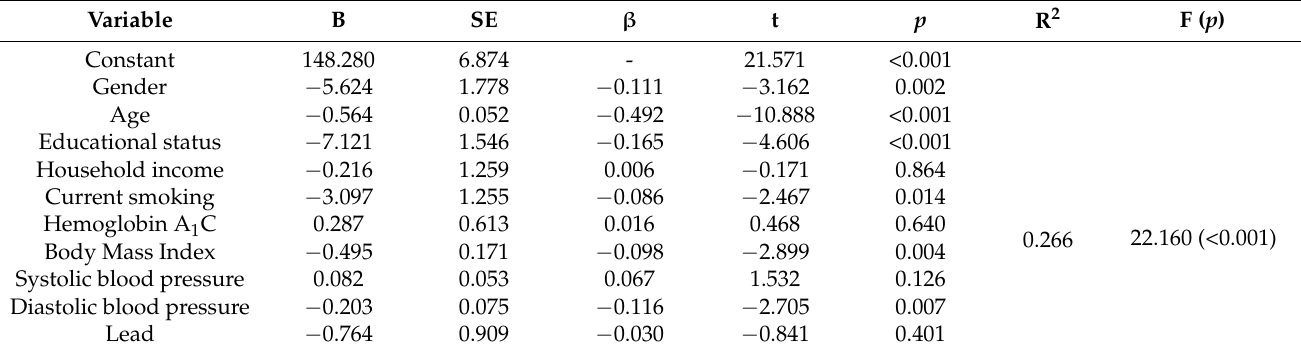
Table 3. Multiple regression analysis according to